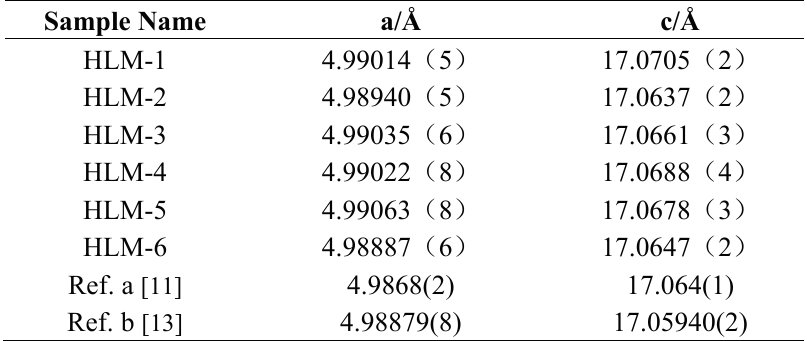
absorption edges of travertine and 2, 3